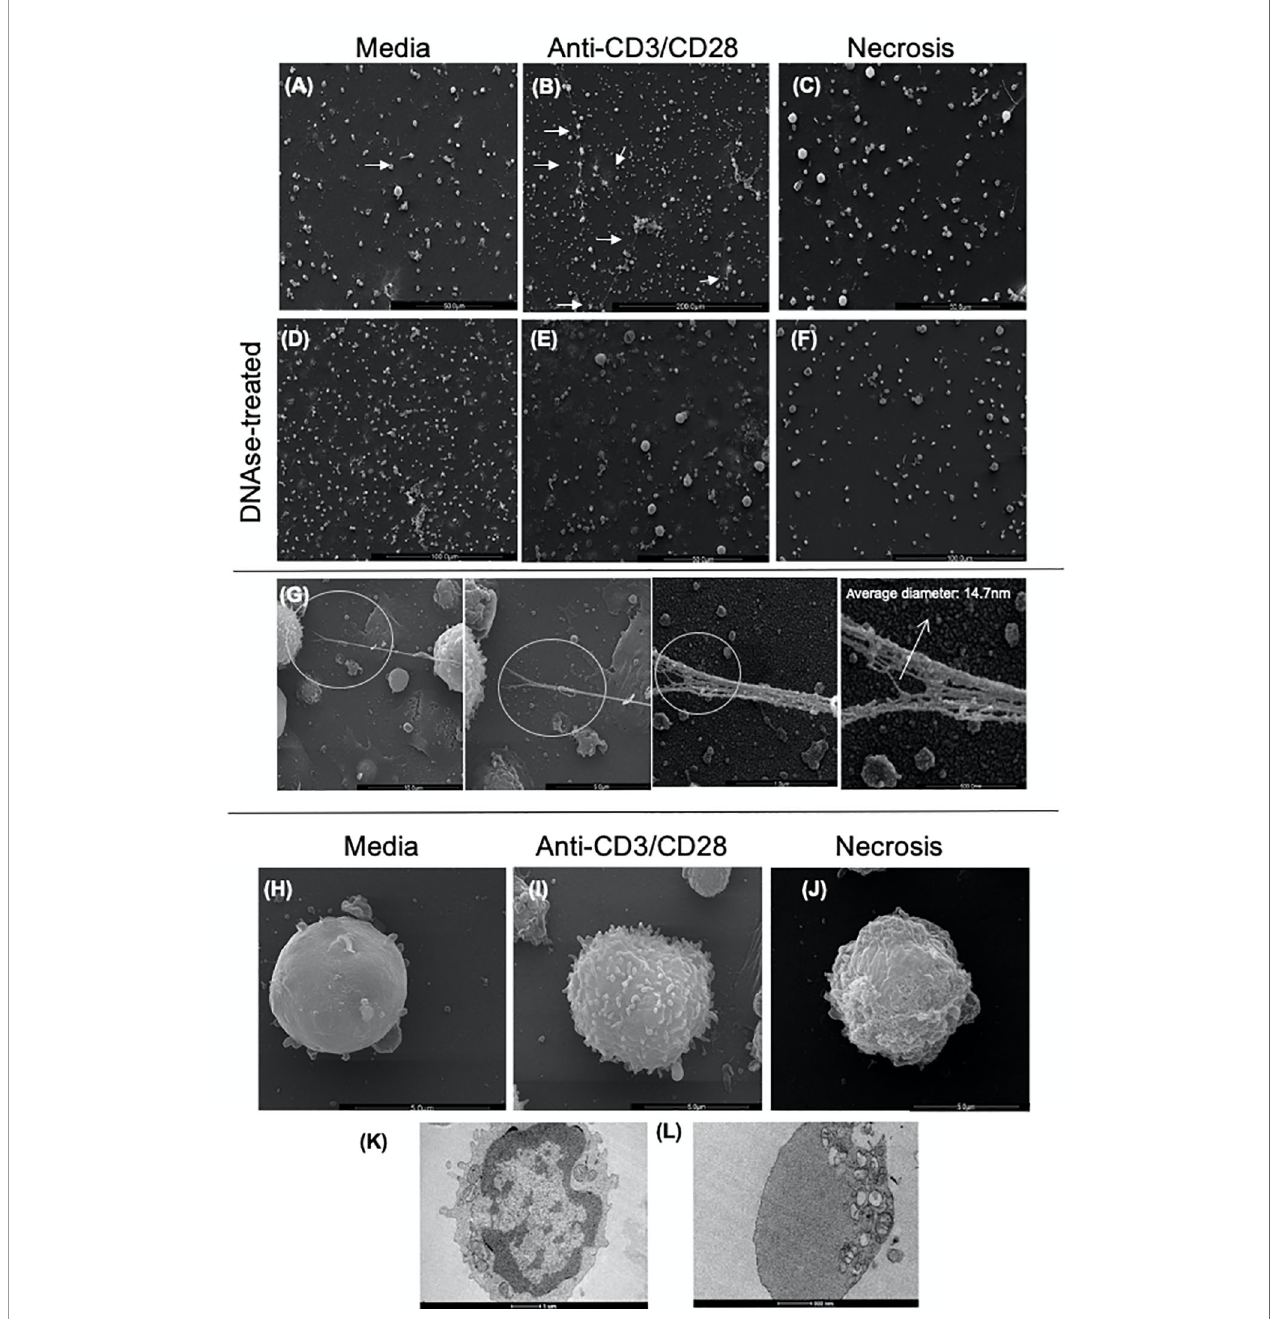
FIGURE 2 | Scanning and transmission electron microscopy of cultures enriched in T lymphocytes show the presence of extracellular traps (ETs). Representative scanning electron microscopy images of (A) Non-stimulated culture (media), (B) Culture stimulated with anti-CD3/anti-CD28, (C) Necrosis-induced culture (necrosis). In the (A – C) images, the arrows indicate structures compatible with extracellular traps (arrows). (D) Non-stimulated culture treated with DNAse (DNAse-treated media), (E) Culture stimulated with anti-CD3/anti-CD28 treated with DNAse, (F) Culture of cells induced to necrosis treated with DNAse (DNAse-treated necrosis). (G) Detail of an ET (extracellular DNA) present in a culture enriched with T lymphocytes after anti-CD3/anti-CD28 stimulation. High-resolution SEM analysis of ETs that consist of fi bers with an average diameter of 14.7 nm, arrow. Scanning electron microscopy images of cell topography under different conditions, showing the distinction amongst them: media (H) , anti-CD3/anti-CD28 (I) , and necrotic (J) . Transmission electron microscopy of (K) unstimulated T cell; (L) cell in etosis present in culture stimulated with